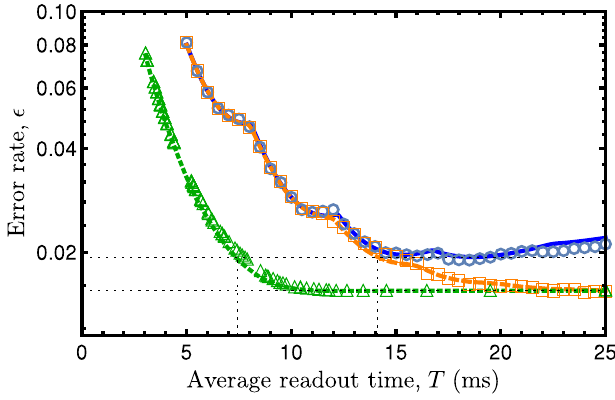
FIG. 5. Error rate as a function of average readout time for the experimental parameters of Sec. IV B. The lines give the Monte Carlo simulated error rate, and the symbols give the experimental values corrected for preparation errors using Eq. (E7). We display the error rate for the photon-counting model discussed in Appendix D (solid blue and blue circles), for the nonadaptive MLE (dashed orange and orange squares), and for the adaptive MLE (dotted green and green triangles). The horizontal dotted black lines indicate the minimum error rate of the photon-counting (1.9%) and MLE methods (1.5%). As indicated by the vertical dotted black lines, the speedup of the adaptive MLE compared to the nonadaptive MLE is t when the target error rate is the minimum error rate of the photon- counting